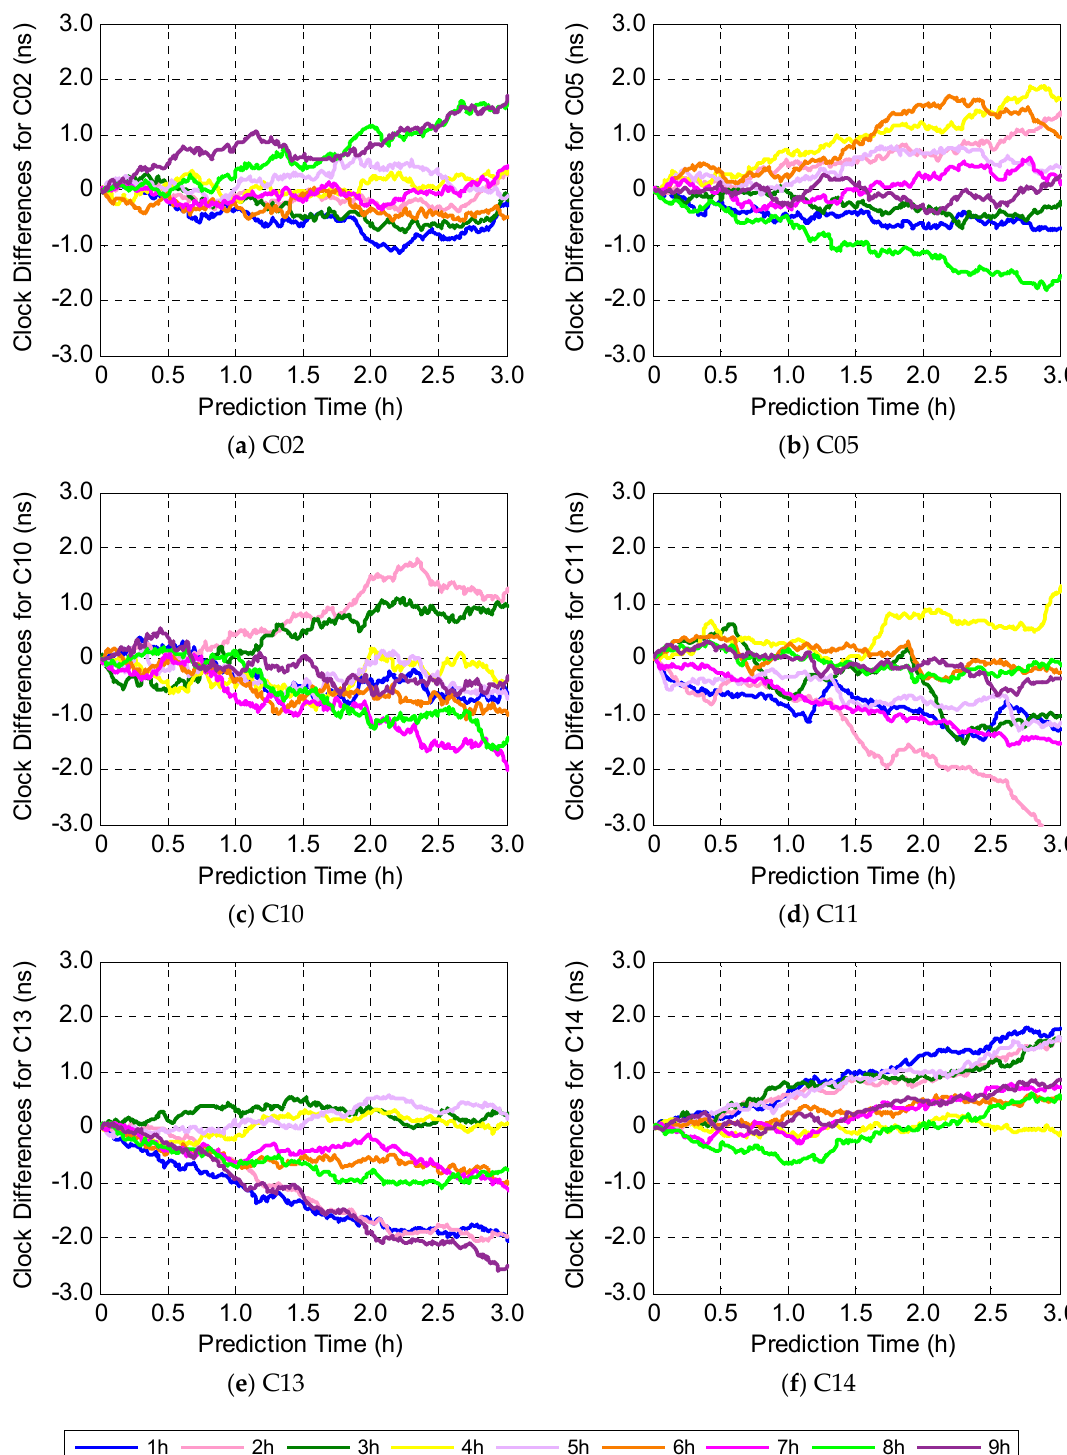
Figure 5. Clock differences between true (German Research Centre for Geosciences (GFZ) precise clock products) and prediction, using different lengths of input data.